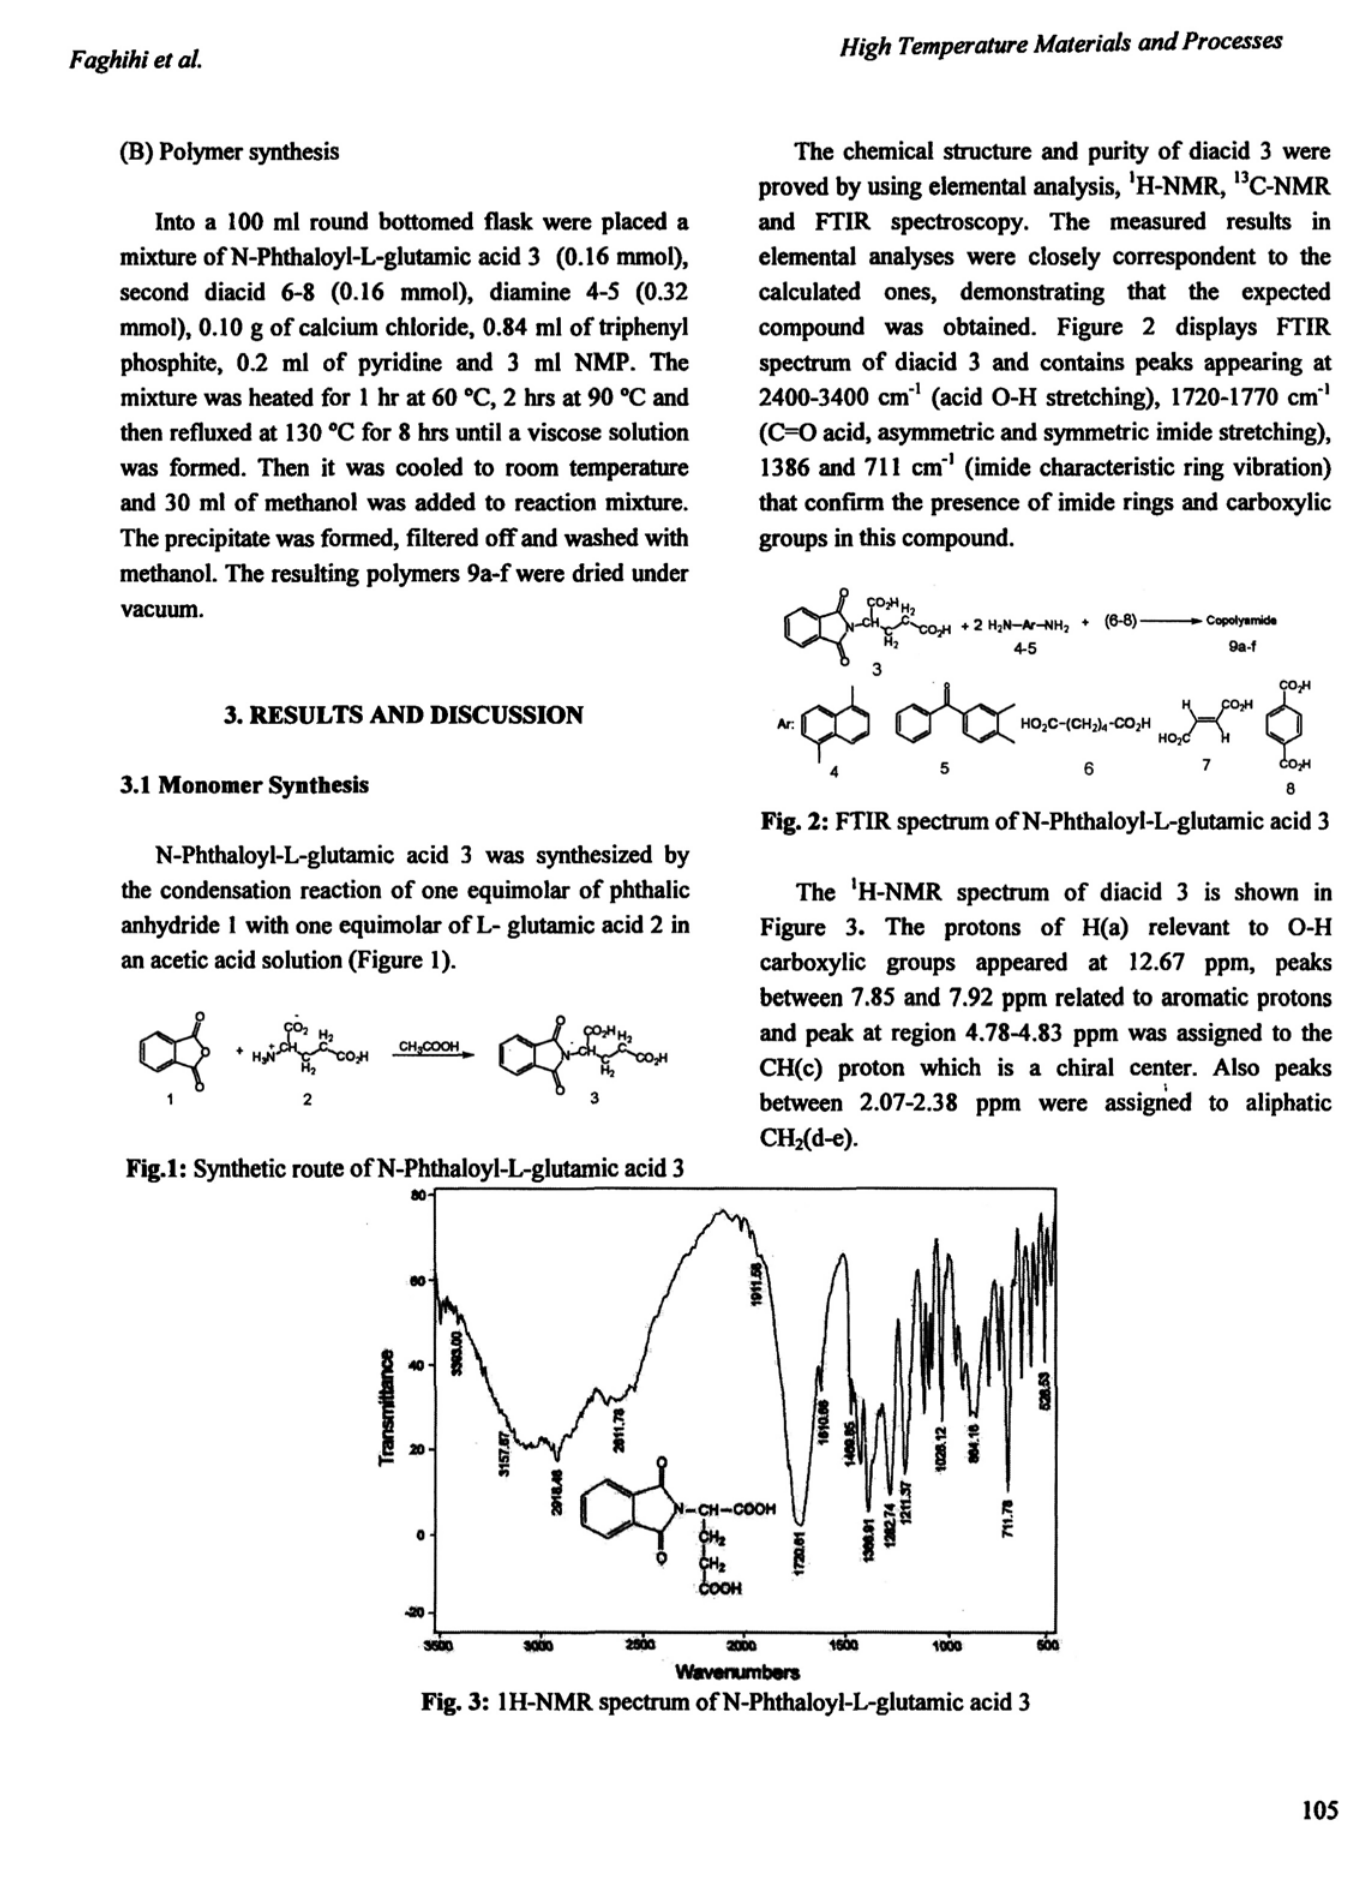
Fig. 3: 1H-NMR spectrum of N-Phthaloyl-L-glutamic acid